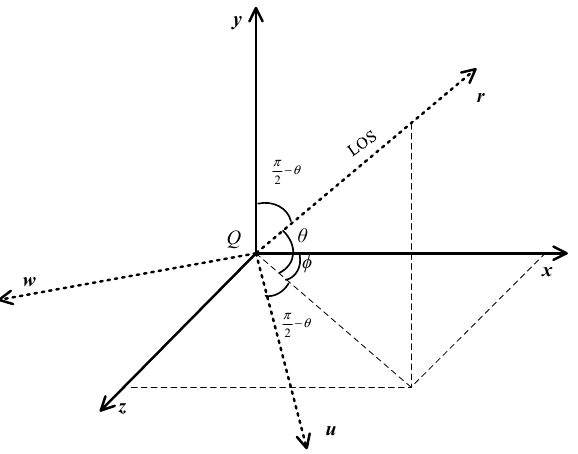
Figure 3. Rotation of coordinate systems.